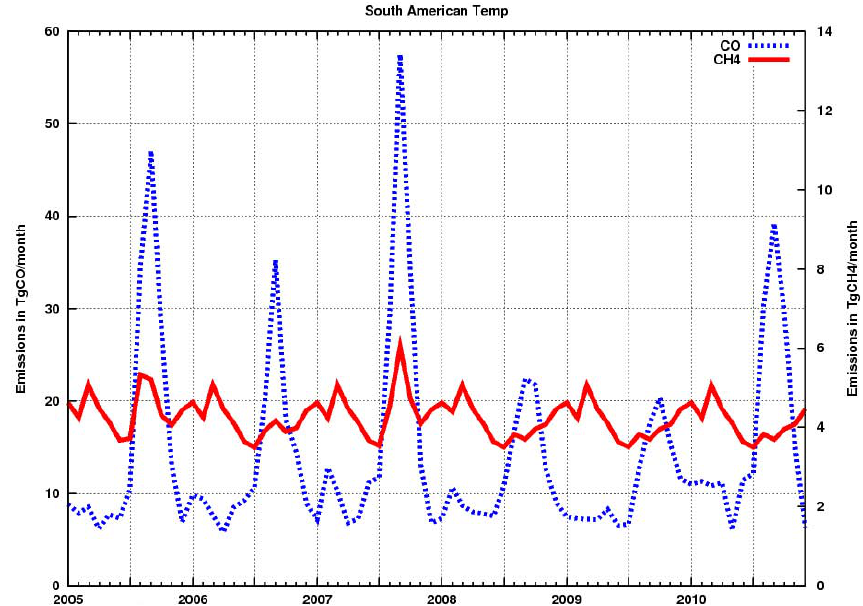
Fig. 9. Seasonal cycles of the posterior CO and CH 4 emissions for the tropical region South American Temperate, respectively in TgCO/month and TgCH 4 /month, from January 2005 to December 2010. Table 6. Details of the sensitivity studies described in Sect. 6. The changes between the different sensitivity tests are highlighted in bold. OH HCHO production by CO